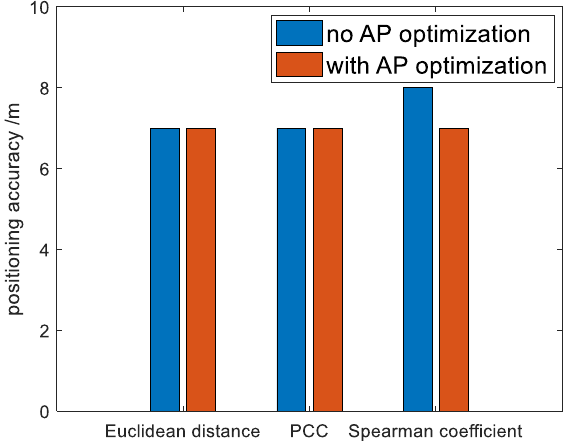
Figure 11. Comparison of positioning accuracy.